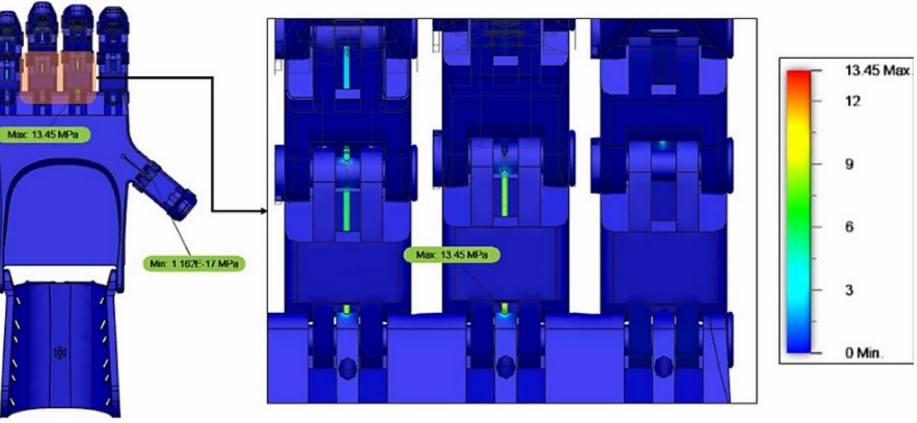
Figure 20. Color map for stress